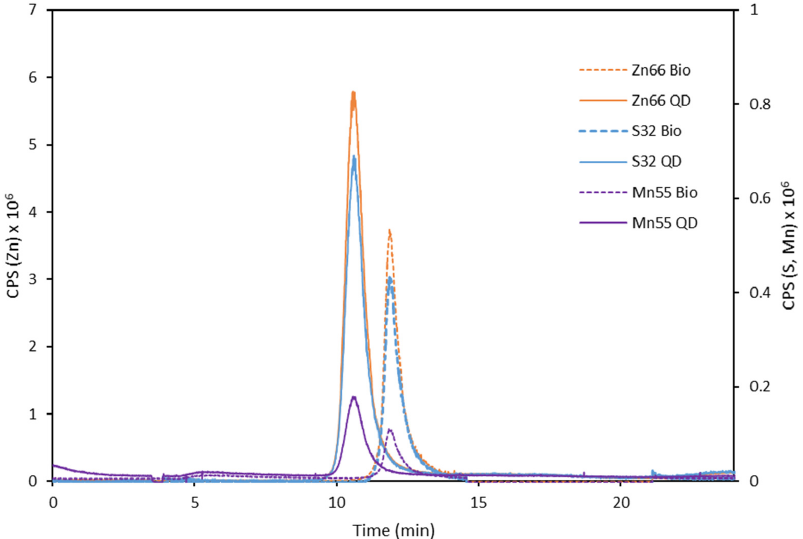
Figure 3. Elemental profiles obtained by asymmetric flow field-flow fractionation coupled on-line to an ICP-MS/MS (AF4-ICP-MS/MS): Quantum Dots (QD) in continuous lines, QD-Antibody (QD- Ab) bioconjugate (Bio) in dotted lines. Orange, 64 Zn + → 64 Zn + ; purple, 55 Mn + → 55 Mn + ; blue, 32 S + → 48 SO +